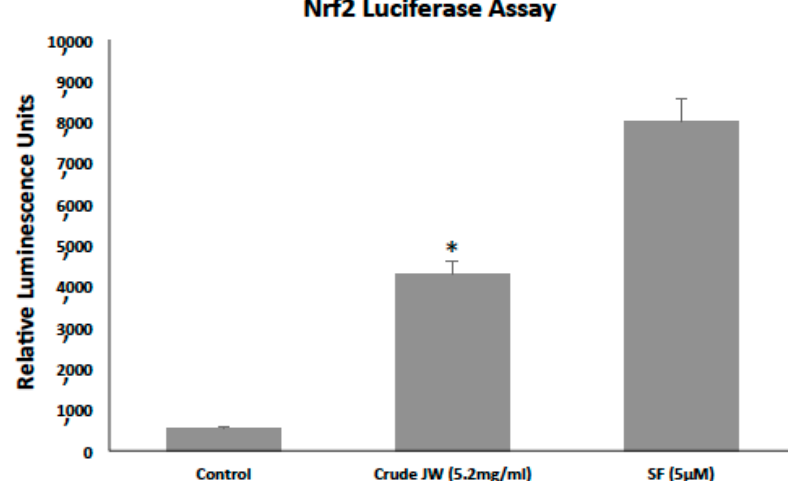
Figure 3. The effect of the crude on Nrf2 in ARE reporter-Hep G2 cells. Cells were seeded in 96-well plates at a density of 4 × 10 4 cells/well and incubated for 24 h. The cells were further treated with 5.2 mg/mL concentration of crude Jing liqueur for additional 24 h. The negative control cells were treated with 0.2% DMSO (dimethyl sulfoxide), and positive control cells were treated with 5 μ M DL-sulforaphane (SF). Luciferase activity was determined. * p < 0.05.